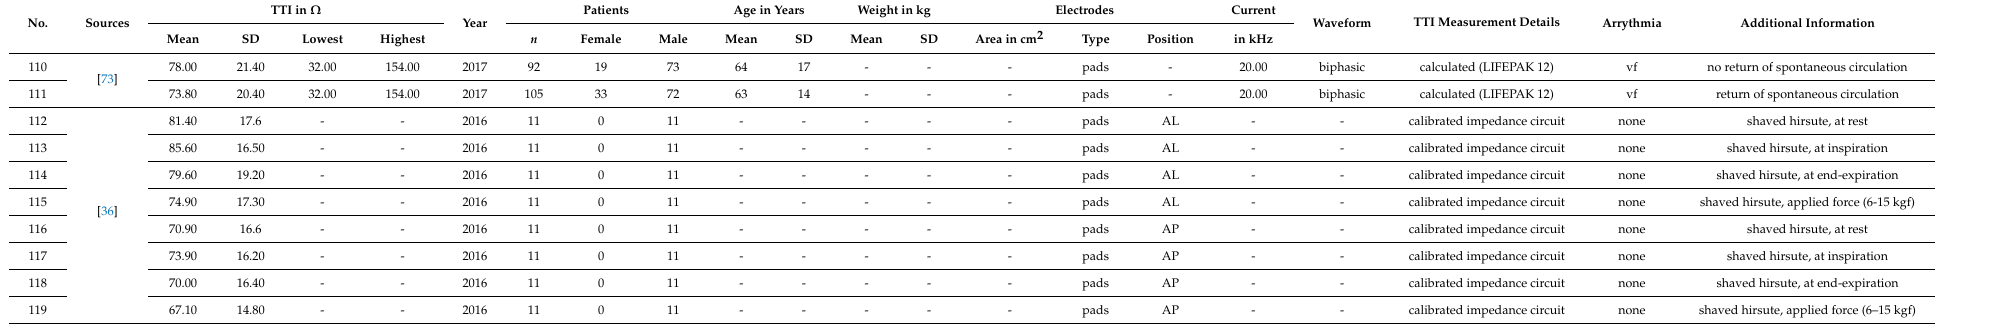
Table explanations: ‘-’ stands for missing data; Electrode areas are given as first electrode/second electrode; card. electrode = cardioversion electrode; energy is given in min-max energy; none = no defibrillation shock and/or arrhythmia; defi. = defibrillation; AA, AL, AP, vf, vt, af, va, aa see